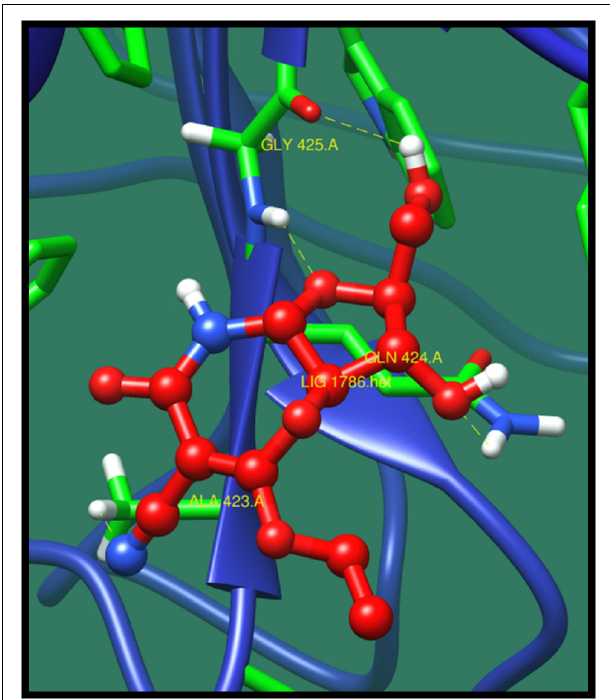
FIGURE 7 | Interaction of penicillin-binding protein 2A with ZINC16942644 (colored in red). The interacting residues (green) are shown bonding (dotted lines) with the